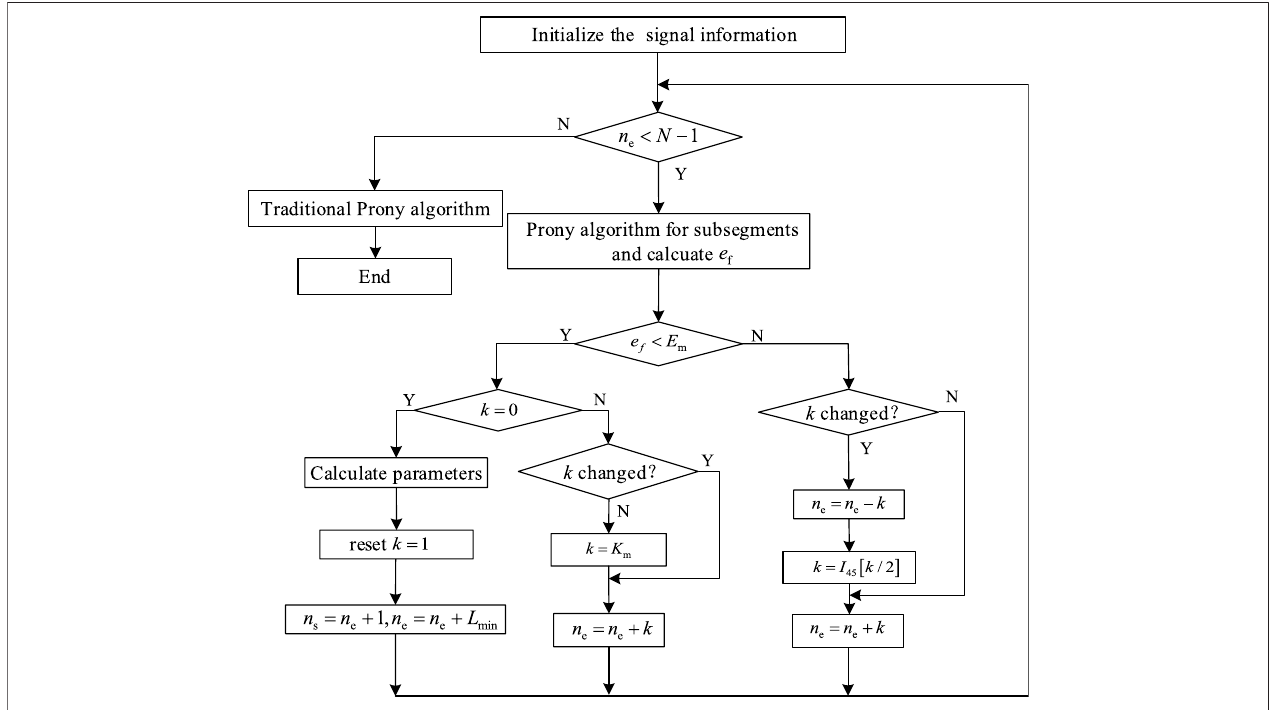
FIGURE 1 | Flowchart of the proposed, improved adaptive Prony